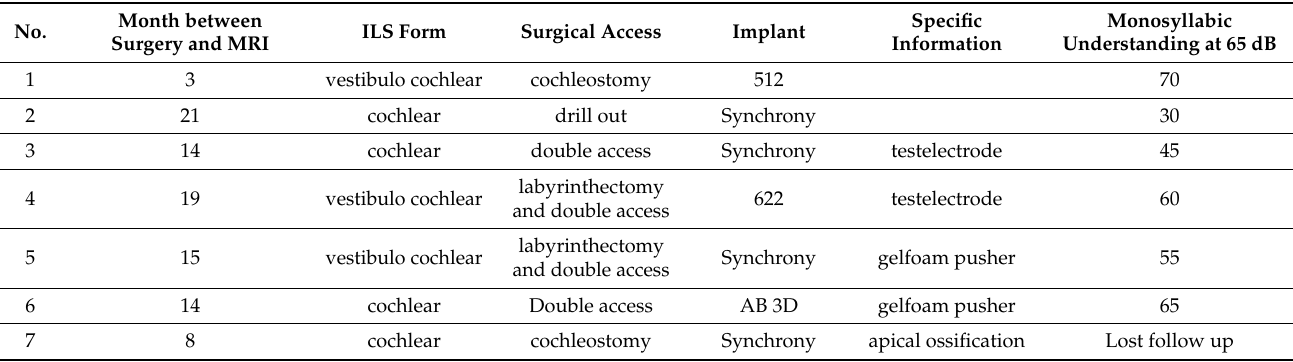
Table 1. Description of individual data. Period between surgery and control MRI; surgical access to the cochlea (single: extended cochleostomy; double: extended cochleostomy and second turn access; lab.: labyrinthectomy); specific information is about additional techniques performed for tumor removal and anatomic variations; hearing outcome by monosyllabic words quietly at 65